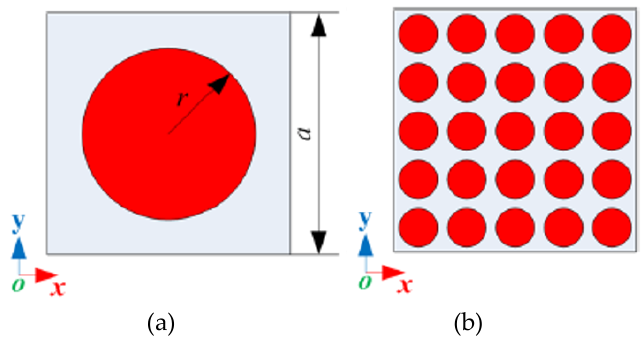
Figure 3. Proposed metamaterial with defect states [12].